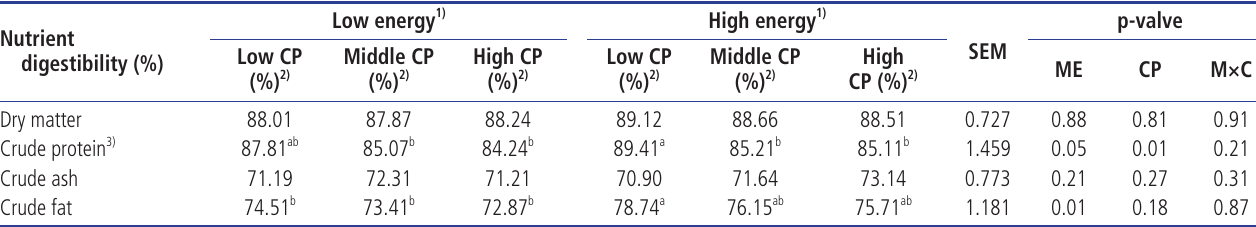
Table 5. Effects of dietary energy and crude protein levels on nutrient digestibility in weaning pigs Nutrient digestibility